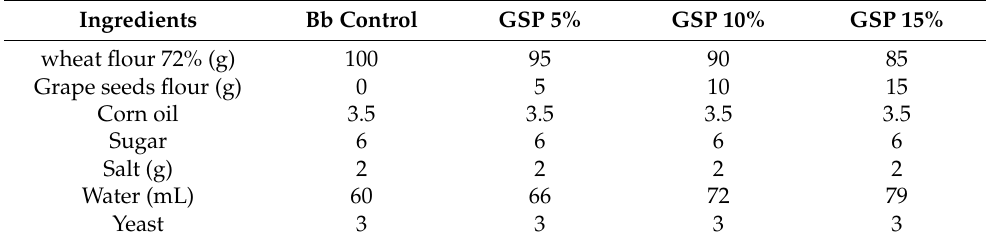
Table 1. Balady bread (Bb) with different concentrations of grape seeds powder (g/100 g).